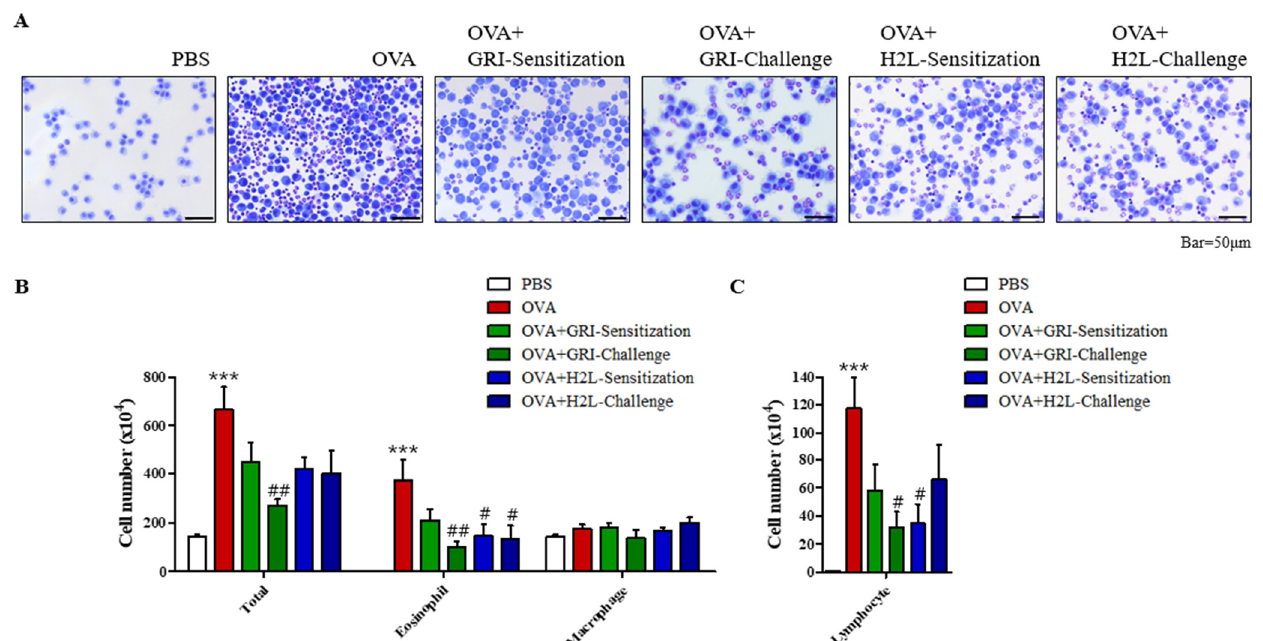
Figure 2. H2L5186303 and GRI977143 inhibit ovalbumin-induced immune cell accumulation in BALF. ( A ) Mice were sensitized with ovalbumin (OVA) twice via intraperitoneal injection on days 0 (D0) and 14 (D14) and challenged on D28, D29, and D30 with nebulized OVA. H2L5186303 or GRI977143 was administered intraperitoneally at a dose of 1 mg/kg 30 min before OVA sensitization or challenge. BALF cells were stained with May–Grünwald stain and counted. ( B ) Total cell, macrophage, and eosinophil counts in BALF. ( C ) Lymphocyte counts in BALF. The results are presented as mean ± standard error (SE) of the cell count values ( n = 5). *** p < 0.001 vs. the phosphate buffered saline ‐ treated group, # p < 0.05, ## p < 0.01 vs. the OVA ‐ treated group.